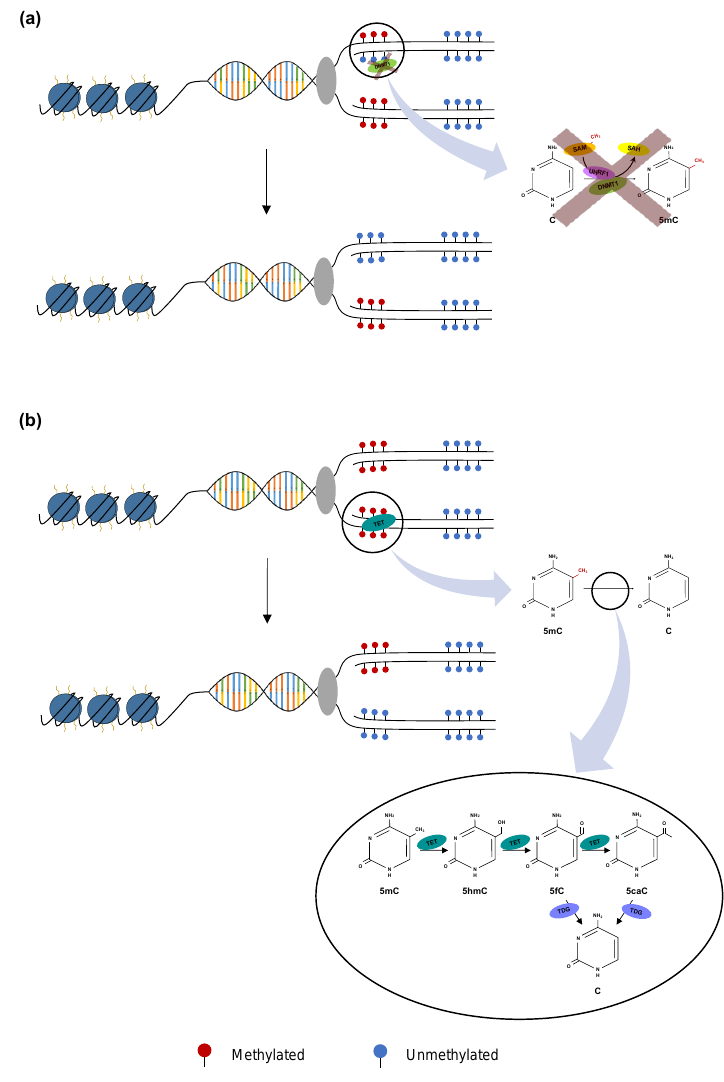
Figure 2. Mechanisms of DNA demethylation ( a ) Passive demethylation. This process occurs during replication wherein one or more limiting factor (i.e., compromised DNMT function, absence of SAM) prevents methylation maintenance and results in the subsequent loss of 5mC residues. ( b ) Active demethylation. Shown are the ten-eleven translocation (TET) enzymes (TET1, TET2 or TET3) (teal) catalyzing stepwise oxidation of 5mC. 5mC is first converted to 5-hydoxymethylcytosine (5hmC) which is further oxidized to 5-formylcytosine (5fC) and finally to 5-carbocylcytosine (5caC). 5fC and 5caC intermediates can be recognized and removed by thymine DNA glycosylase (TDG) (violet). They are then replaced with an unmethylated cytosine nucleotide to complete the base excision repair (BER)